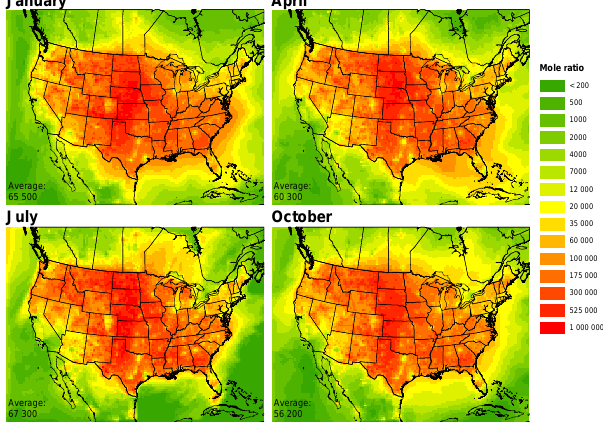
Figure 8. Modeled monthly averaged SO 2 / (D 4 + D 5 + D 6 ) mole ratio by season.